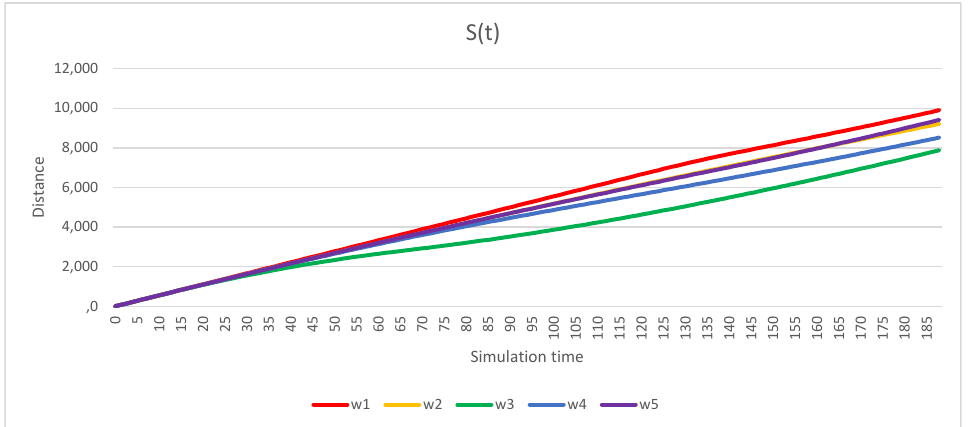
Figure 10. Change in distance traveled S(t) in simulation by context 2 for distance D 0 = D gr = 4000 m.